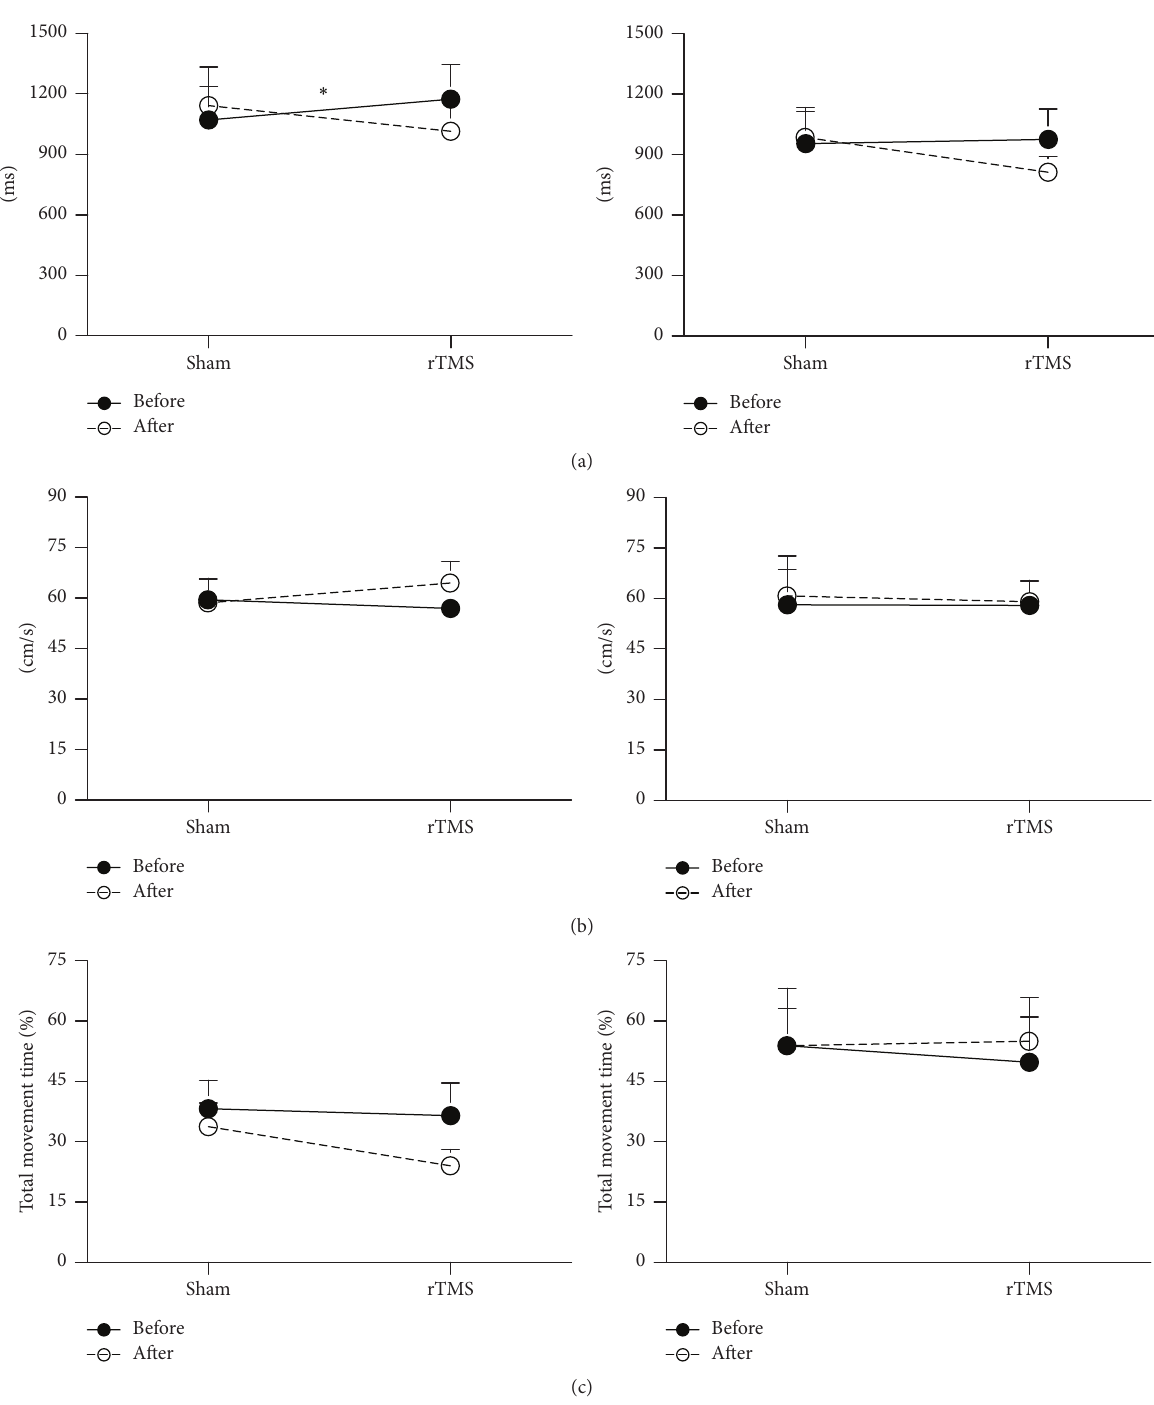
Figure 3: Kinematic parameters of the transport phase for the small object (left) and the large object (right) pre (—) and post (---) each TMS condition. (a) Effect on total movement time. (b) Effect on peak transport velocity. (c) Effect on time of peak transport velocity. ∗ indicates a significant interaction between the TMS condition and time. Error bar =